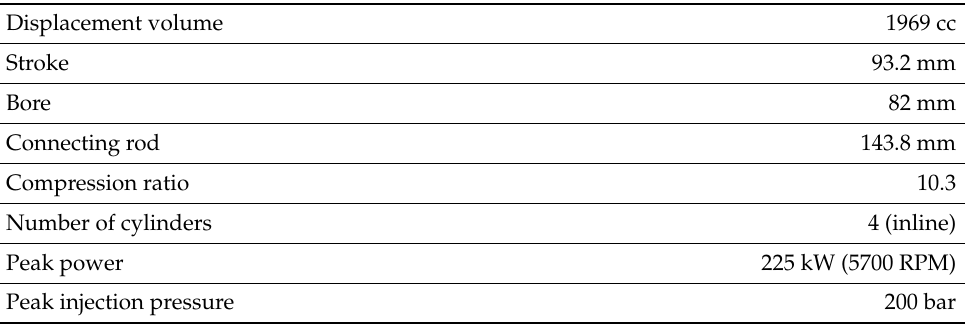
Figure 1. Schematic figure of the experimental setup used including temperatures, where, m air is the mass air flow, m fuel is the mass fuel flow, P cyl is the in-cylinder pressure, T exh is the exhaust temperature, λ is the excess air ratio and T afterTWC is the temperature after the TWC. The value of 345 ◦ C is the temperature measured at the outlet of the first diluter stage, and 40 ◦ C is the temperature measured at the outlet of the second diluter stage. Table 1. Specifications of the test engine used, Volvo Cars T6 DISI